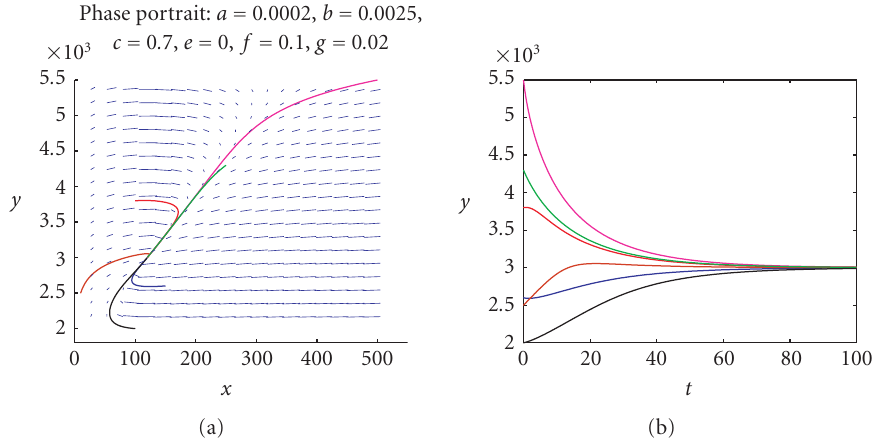
Figure 3.12. A stable node is seen when c < 1, A > 0. Compare with Figure 3.3(b). The fixed point occurs at x 0 = 120, y 0 =